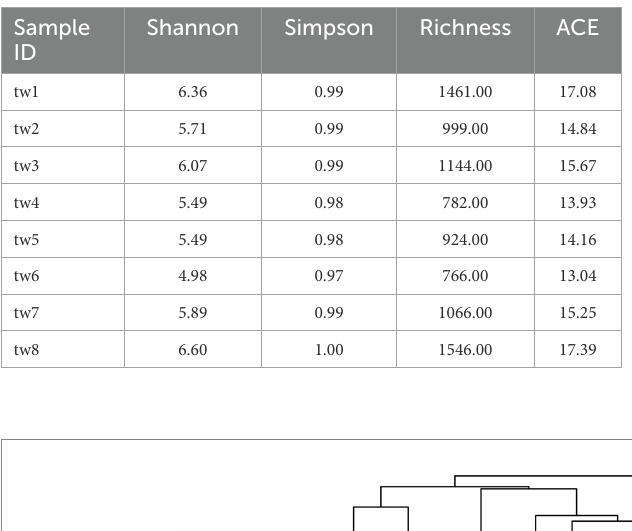
TABLE 1 The alpha diversity index of each sample.